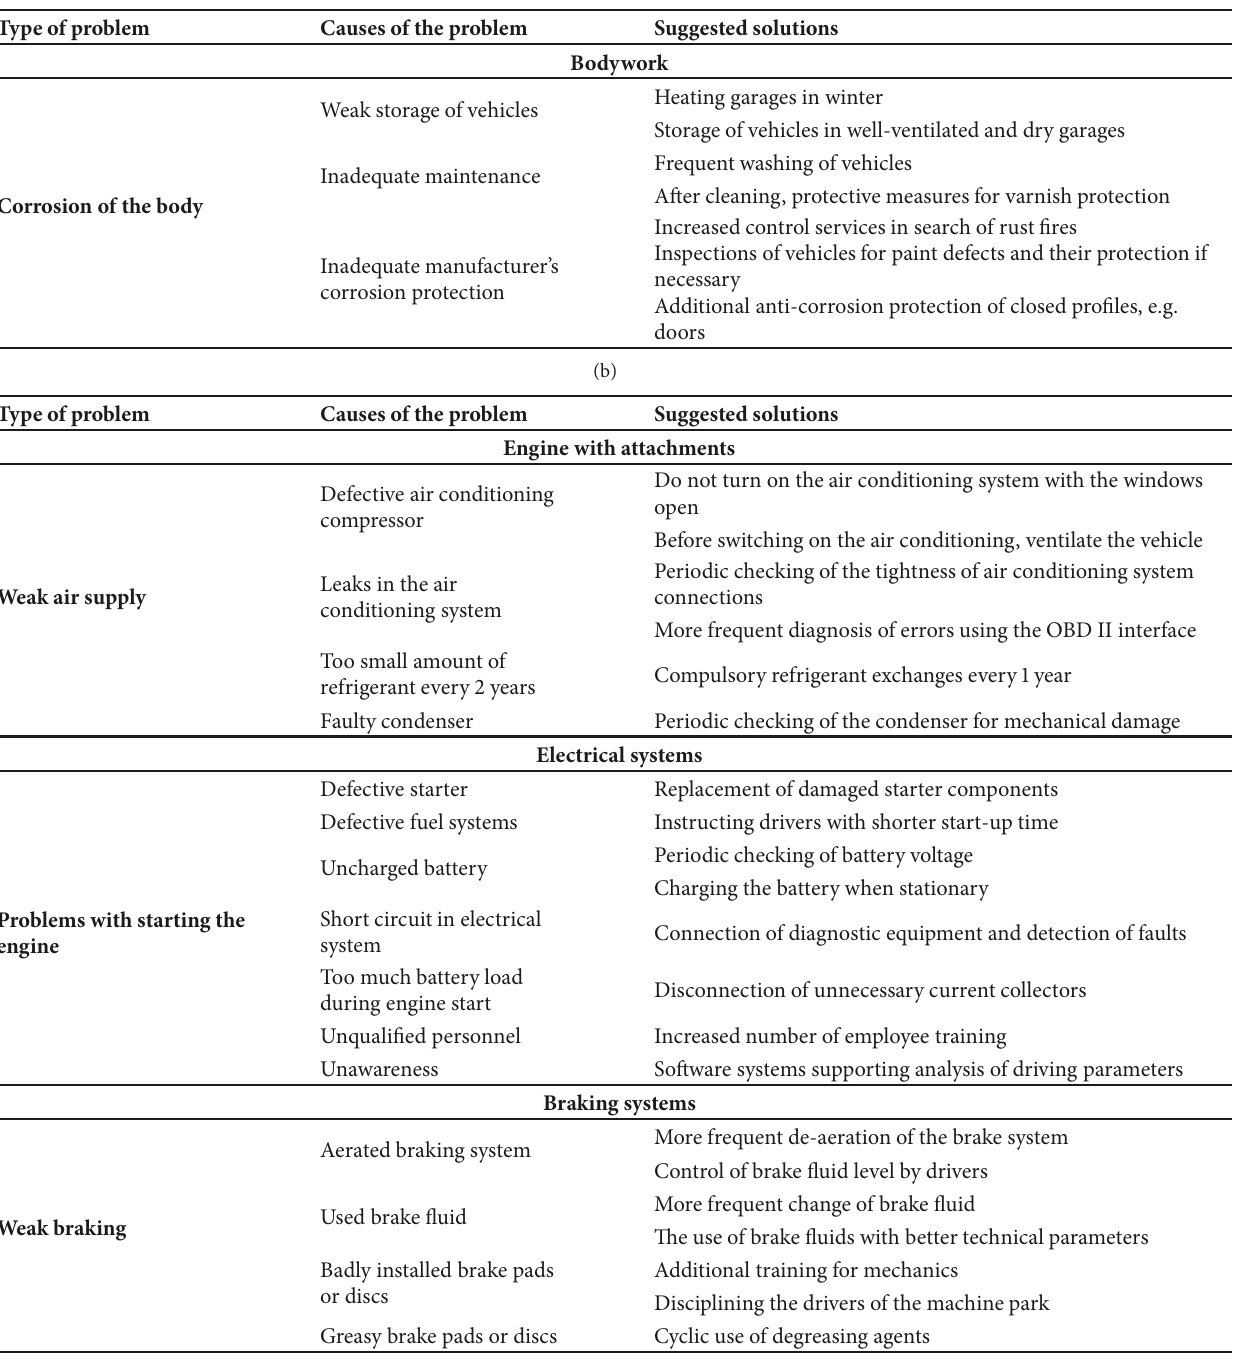
Table 2: Proposed solutions for detected